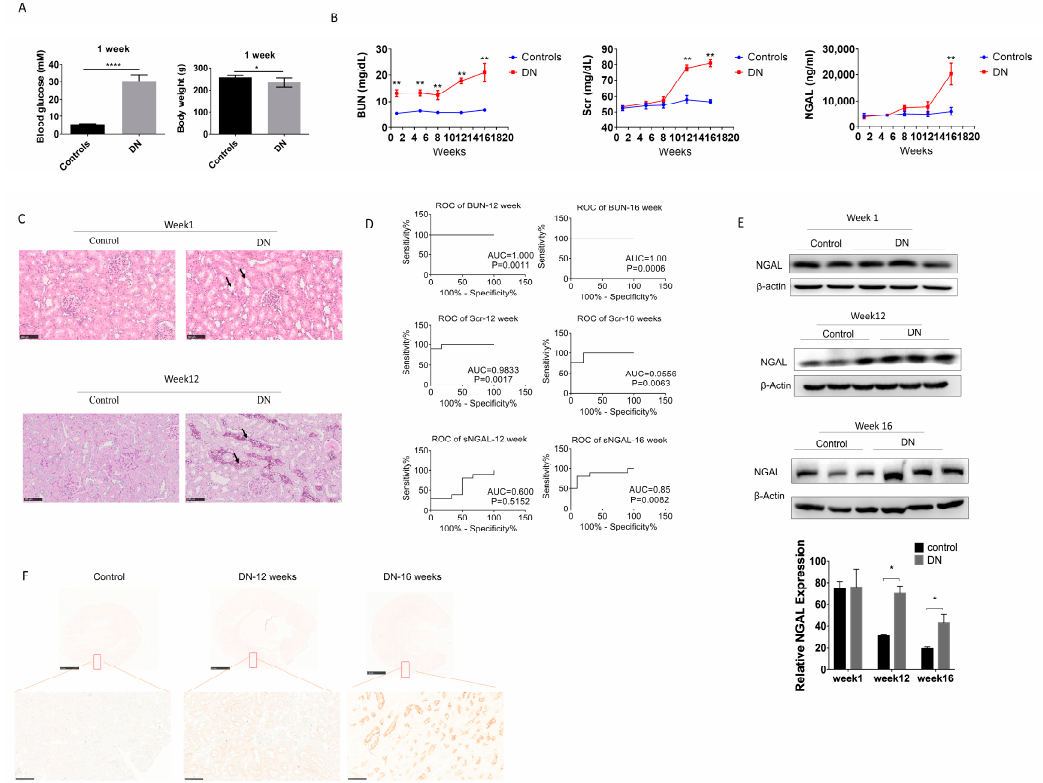
Figure 4. Serum NGAL fails to predict kidney injury in STZ-induced diabetic nephropathy in early stages. ( A ) Comparison of body weight and blood glucose one week after STZ injection. ( B ) BUN, Scr, and sNGAL in experimental diabetic nephropathy (DN) and control groups at di ff erent time points. ( C ) Haematoxylin and eosin (H&E) staining of tissue sections at 1 week and 12 weeks after STZ injection. ( D ) Comparison of ROC curves among BUN, Scr, and sNGAL at week 12 and week 16 after STZ injection. ( E ) NGAL protein levels in kidney tissues by western blot at 1 week, 12 weeks, and 16 weeks after STZ injection. ( F ) Representative immunohistochemistry pictures of NGAL at 12 and 16 weeks post glycemia. *, p < 0.05, **, p < 0.01, **** p < 0.0001 ( n = 8 for each